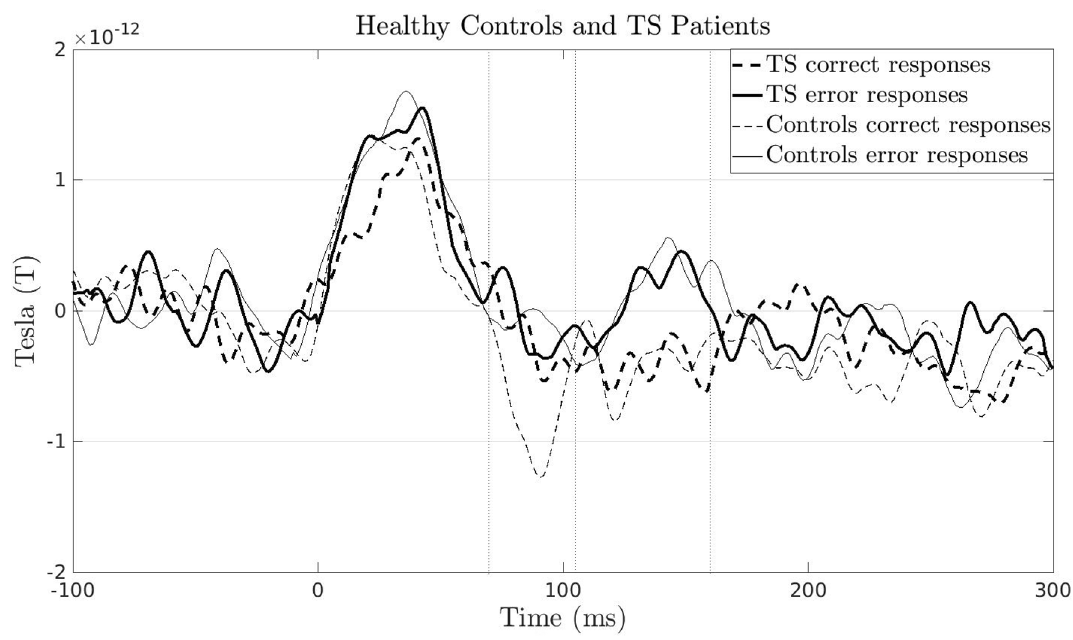
Figure 2. Grand averages of the amplitude of error trials (continuous lines) and correct trials (dashed lines) in healthy controls (thin lines) and TS patients (bold lines) across the selected fronto-central channels. The vertical dotted lines indicate the time range between 70 and 160 ms after response onset showing two components that were inspected separately. Confidence intervals are not provided in the figure, as this would have compromised the visibility of the MEG signals in the different